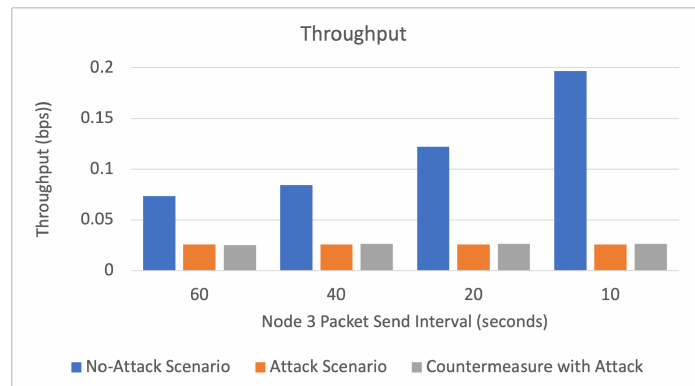
Figure 17. Packet delivery ratio.